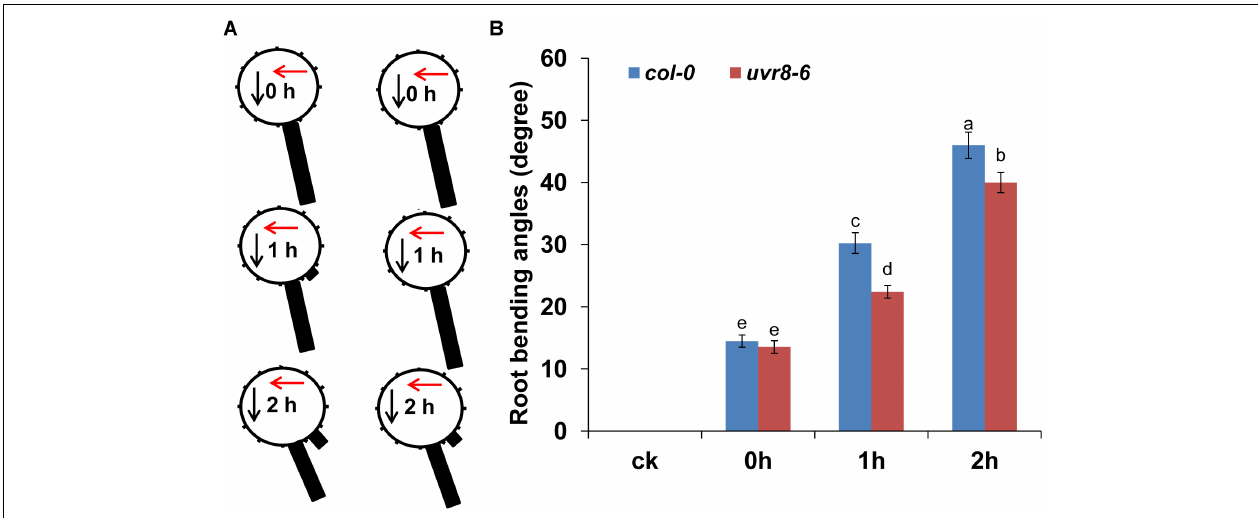
FIGURE 8 | UVR8 is involved in UV-B-induced root bending. The angle of root bending of col-0 and uvr8-6 mutant seedlings irradiated with UV-B for 1 h and then transferred to normal growth conditions for 0–2 h. col-0 , n = 60; uvr8-6 , n = 60. (A) Each gravistimulated root was assigned to 1 of the 12 30 ◦ sectors on a gravitropism diagram. The length of each bar represents the mean percentage of seedlings assigned to the respective sector. The red and black arrows indicate the direction of UV-B-radiation and gravity, respectively. (B) The average root bending angles of col-0 and uvr8-6 seedlings; ck, before UV-B radiation control. The error bars represent the ± SE, and different letters indicate significantly different values ( P < 0.01 by Tukey’s test).